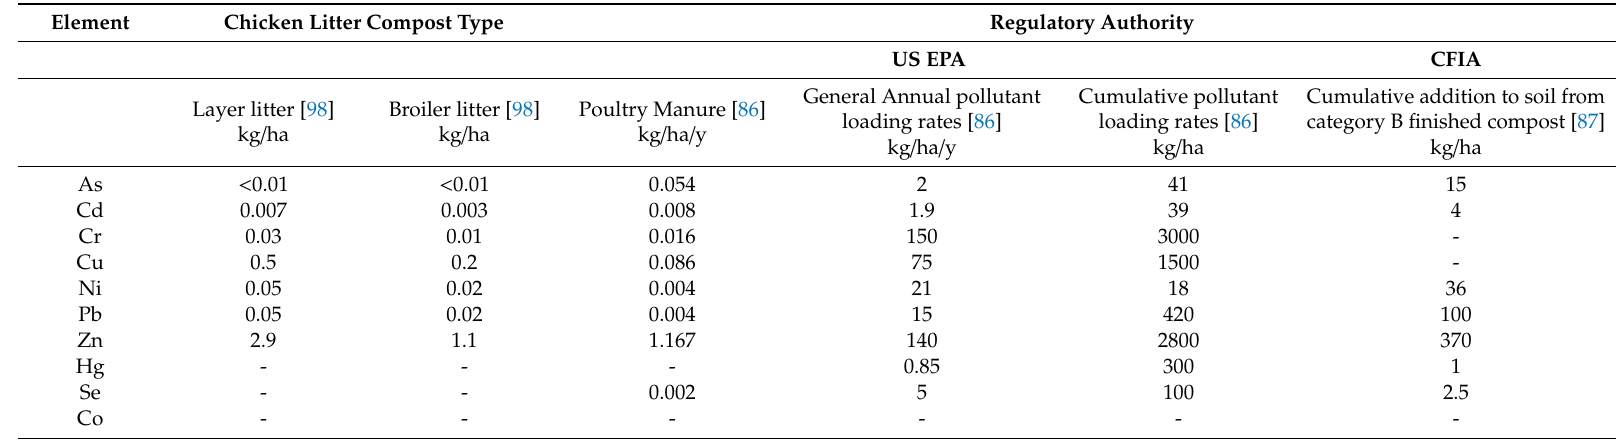
Table 10. Heavy metal input into soil from chicken litter compost at the rate of 250 t / ha and accepted input levels according to di ff erent regulatory